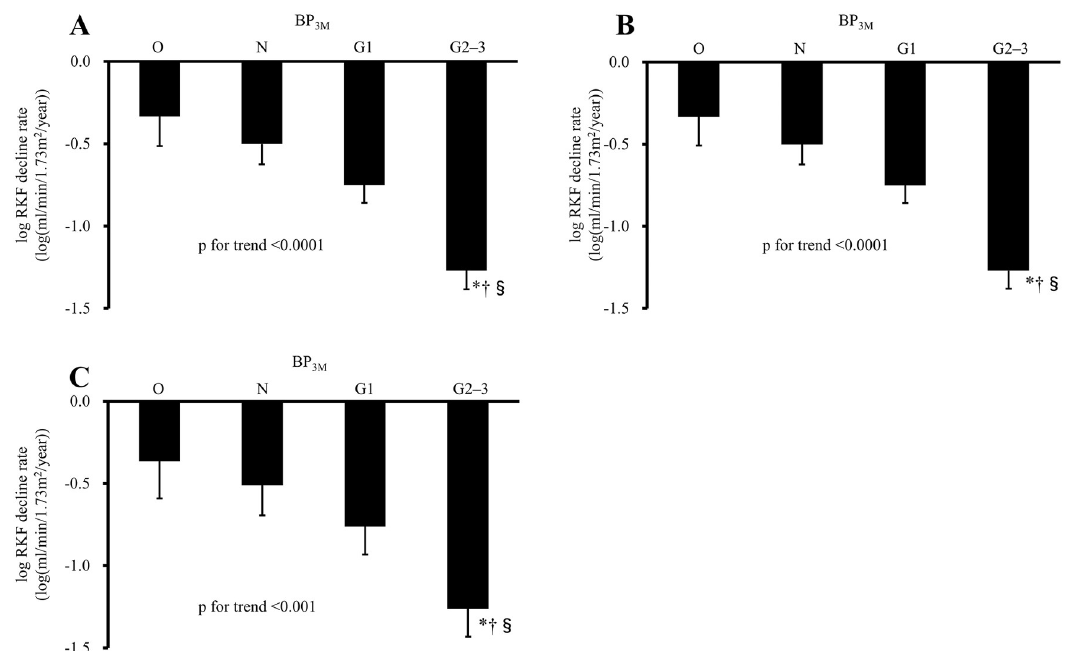
Fig 2. The decline rate of log RKF according to the graded BP 3M groups. A : The unadjusted decline rate of log RKF among the BP 3M groups. B : The sex- and age-adjusted decline rate of log RKF among the BP 3M groups. C : The multivariable-adjusted decline rate of log RKF among the BP 3M groups. � p < 0.01 vs. O, †p < 0.01 vs. N, §p < 0.05 vs. G1. Adjusted covariates are as in Fig 1. Error bars indicate the standard error. Abbreviations are explained in the Fig 1